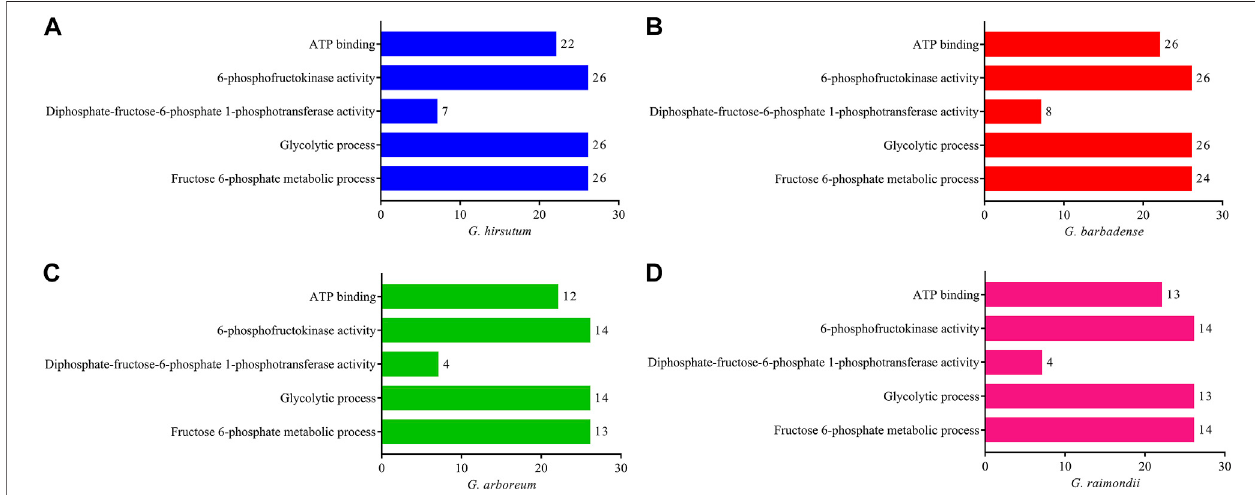
FIGURE 4 | Gene ontology enrichment analysis using CottonFGD for the PFK gene family. (A) G. hirsutum; (B) G. barbadense; (C) G. arboreum; (D) G. raimondii. Bar graph was done using PrismPad; the scale indicates the number of genes enriched in each function.